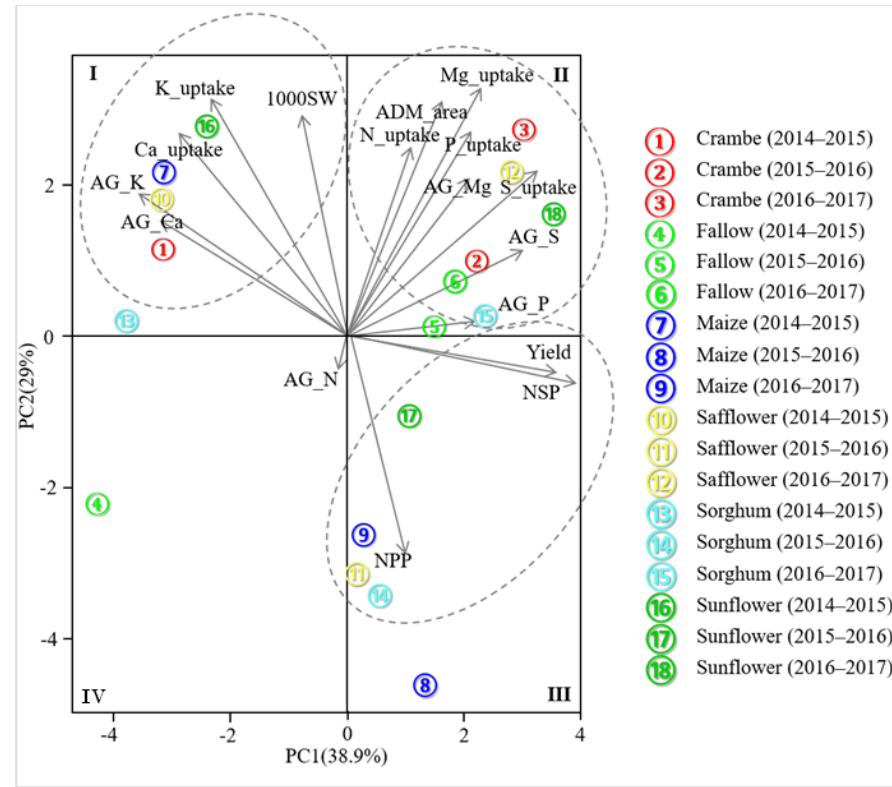
Figure 5. Principal component analysis (PCA) for previous crop treatments, including all growing seasons. Six previous crops in the three growing seasons (numbers from 1 to 18 in the circles) and vectors (yellow arrows) represent trait factor loading coordinates for PC 1 and PC 2. Traits measured in soybean crop were concentrations in aboveground (AG_N, AG_P, AG_K, AG_Ca, AG_Mg e AG_S), macronutrient uptake (N_uptake, P_uptake, K_uptake, Ca_uptake, Mg_uptake e S_uptake), and per-unit area dry matter (ADM_area), number of pods per plant (NPP), number of seeds per pod (NSP), 1000-seed weight (1000SW), and seed yield (Yield). The red lines were drawn to facilitate visualization of groups of treatments and their interrelationships with the variables.